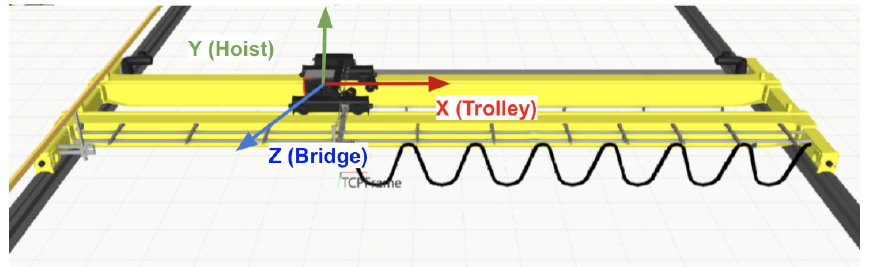
Figure 2. Components of the crane “Ilmatar” (a screen capture of its Visual Component model [28]): Three subsystems enable translational movements in three dimensions—hoist for moving up and down, trolley and bridge for moving backward and forward.